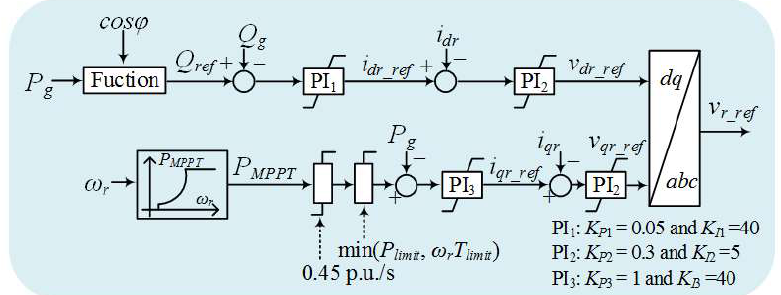
Figure 1. Typical DFIG configuration.